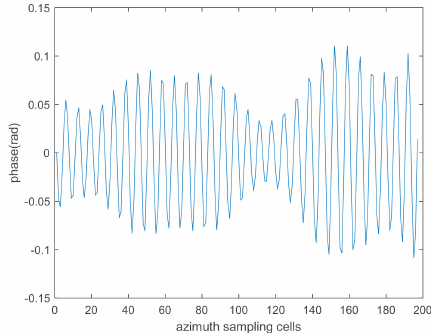
Figure 29. Estimated vibration phase.